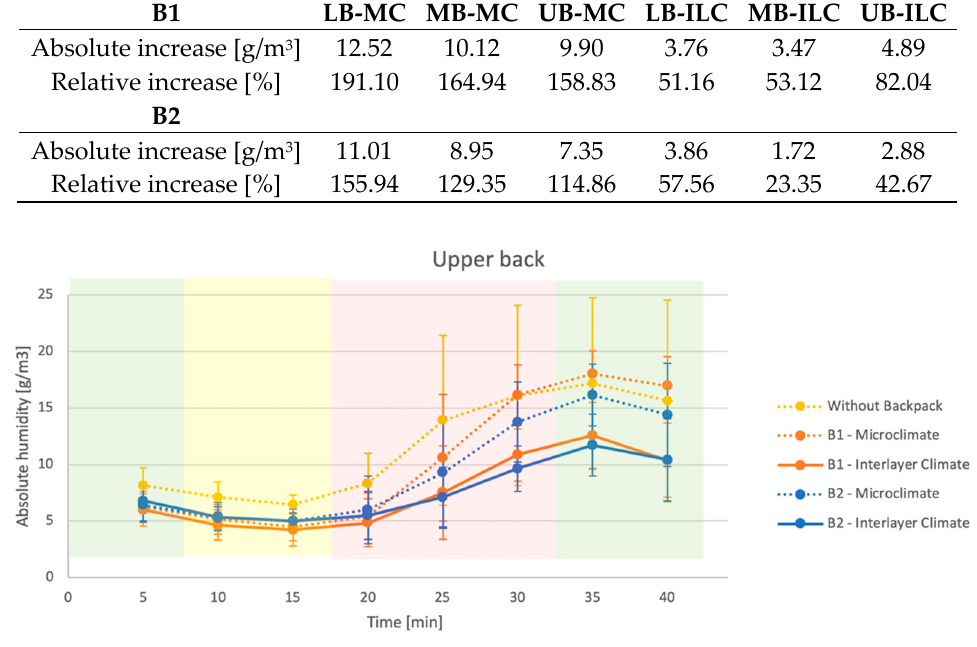
Table 1. Absolute and relative increase of the absolute humidity at the lower back (LB), middle back (MB) and upper back (UB) in the microclimate (MC) and interlayer climate (ILC) from the beginning until 5 min after the end of the exposure (min. 35).